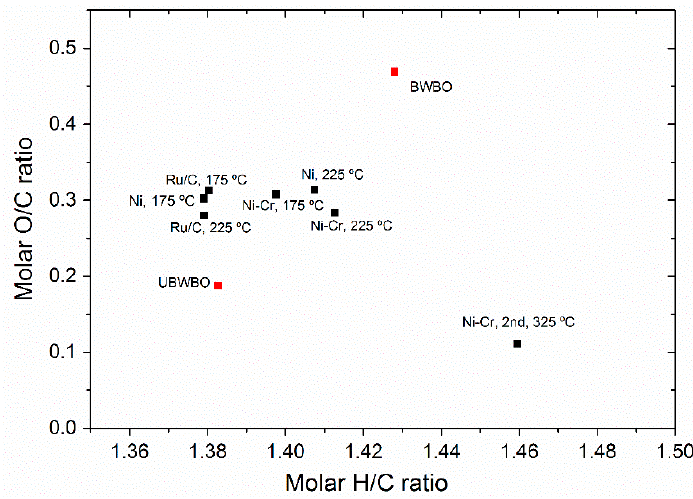
Figure 2. Van Krevelen diagram of the upgraded oils in comparison to the feed (dry basis).